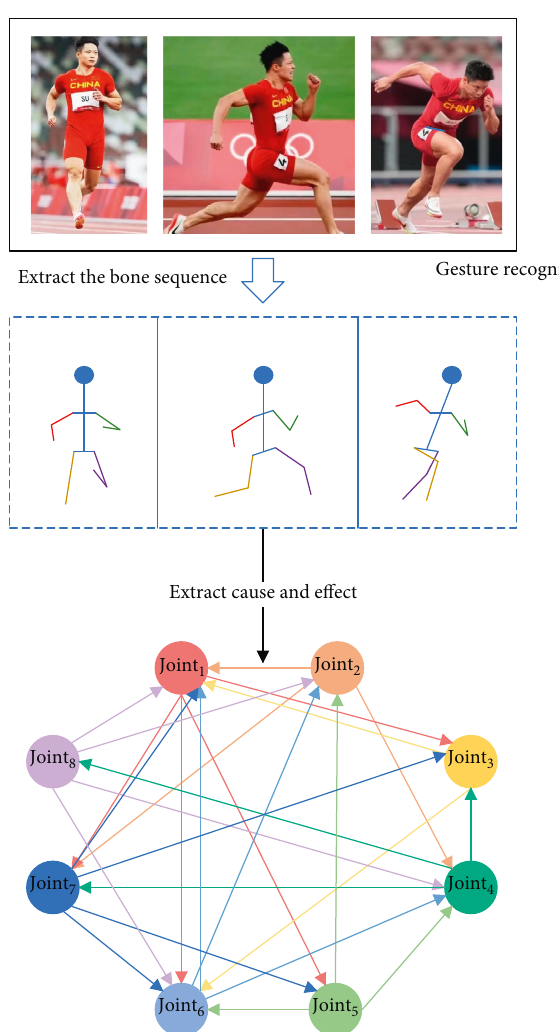
Figure 1: Motion recognition model combining causality and spatiotemporal graph convolution